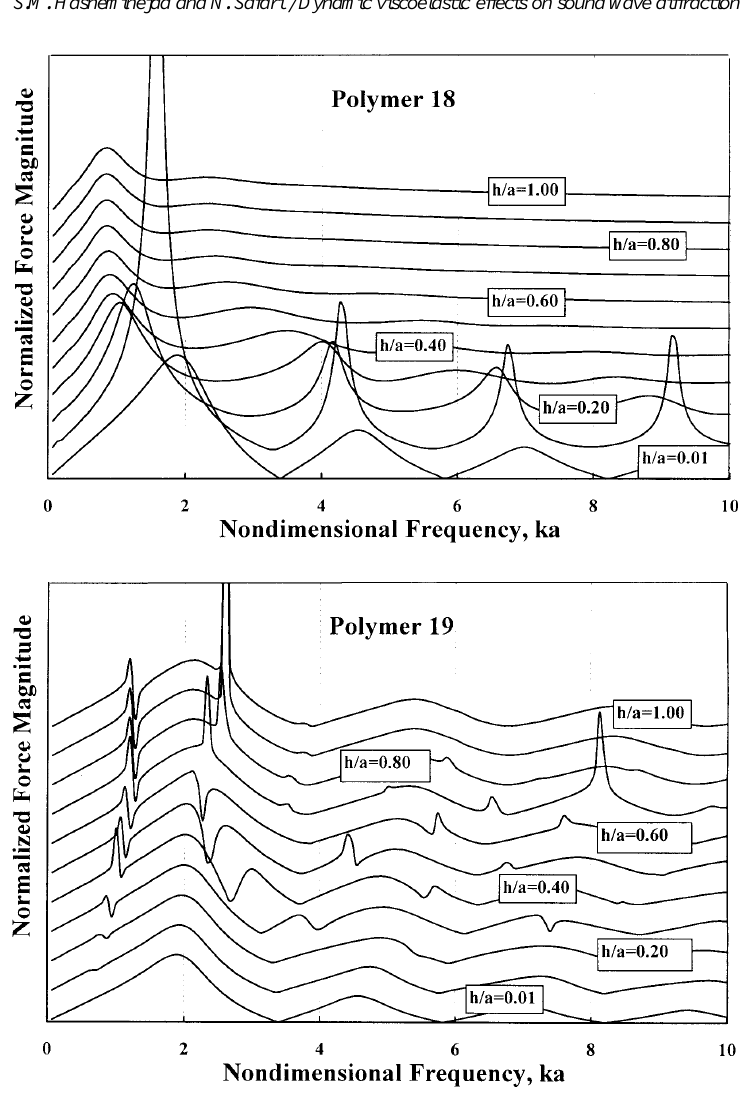
Fig. 5. Variation of the normalized acoustic force magnitude on the fluid-filled spherical viscoelastic shell with the shell thickness. effect of varying each of them. The intent of the collection of data presented here is merely to illustrate the kinds of results to be expected from some representative and physically realistic choices of values for these parameters.